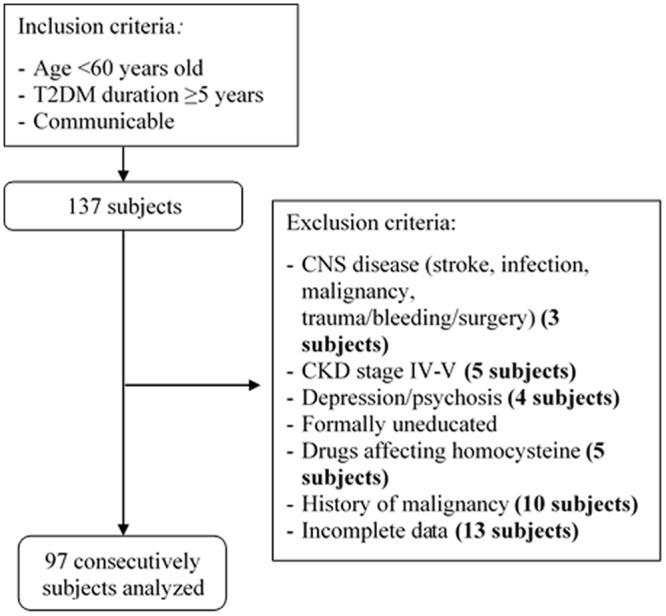
Flow chart of subject recruitment process.